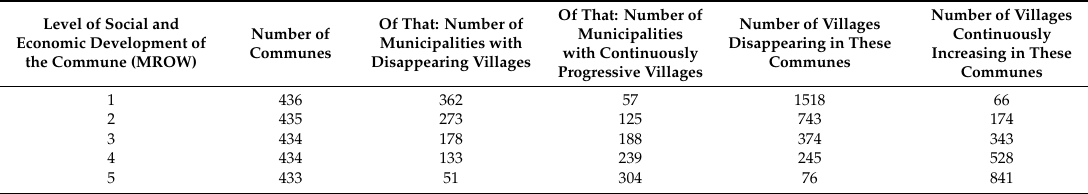
Source: Own study based on CSO